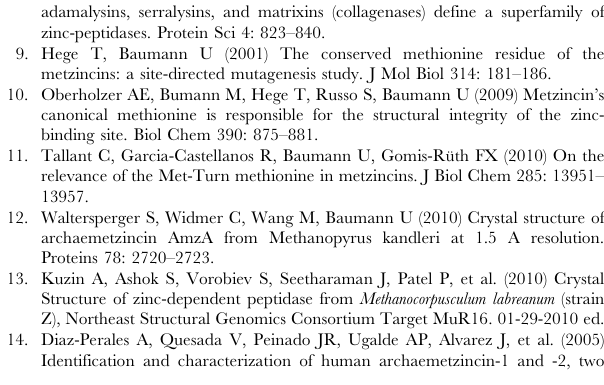
Figure S1 Main chain RMS deviation of the three Af AmzA structures. RMS deviation plots for the main chain atoms of the apo and ligand bound structures. The black line highlights the mean RMSD of 0.4 A˚ . Compared to NHis- Af AmzA residue Asn138 located in the specificity loop shows a RMSD of 1.6 A˚ (nat- Af AmzA::malonate, dotted red line) and 1.8 A˚ (nat- Af AmzA::citrate, solid blue line), respectively. Figure S2 Overlay of M. kandleri AmzA in non-liganded and citrate-bound form. The non-liganded form is depicted in cyan, the citrate-bound form as red ribbon. Citrate is shown as sticks with orange carbon atoms and red oxygens.